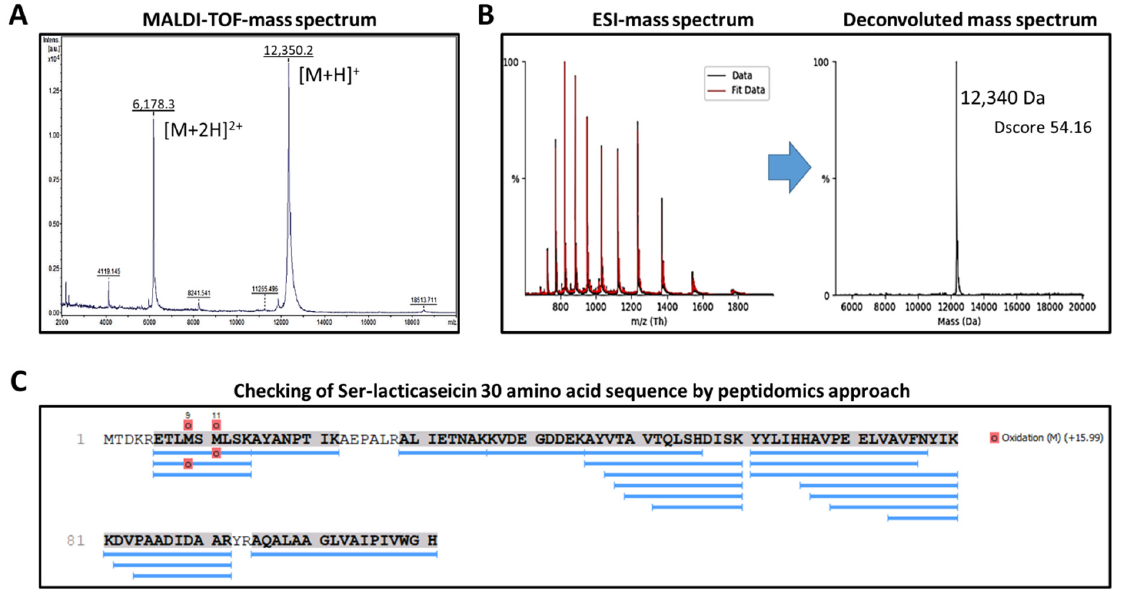
Figure 1. Mass spectrometry analyses of 6his-tag-depleted Ser-lacticaseicin 30 (average molecular mass 12,339.2 Da). ( A ) Linear positive MALDI-TOF mass spectrum illustrating the [M + H] + and [M + 2H] 2+ mass signals obtained. The measured MALDI-TOF-MS molecular mass was evaluated as 12,349.2 Da. ( B ) ESI mass spectrum and deconvoluted molecular mass (UniDec DScore: 54.16) re- vealing a molecular mass of 12,340 Da. ( C ) Peptide mapping of the 6his-tag-depleted Ser-lacticase- icin 30 after tryptic hydrolysis. Blue lines correspond to identified peptides along the lacticaseicin 30 sequence following the bioinformatic retreatment of RP-HPLC-MS/MS data using PEAKS Studio Xpro and the UniProtKB/Swiss-Prot-TrEMBL protein databases restricted to Lactobacillus (https://www.uniprot.org/, accessed on April 2022).